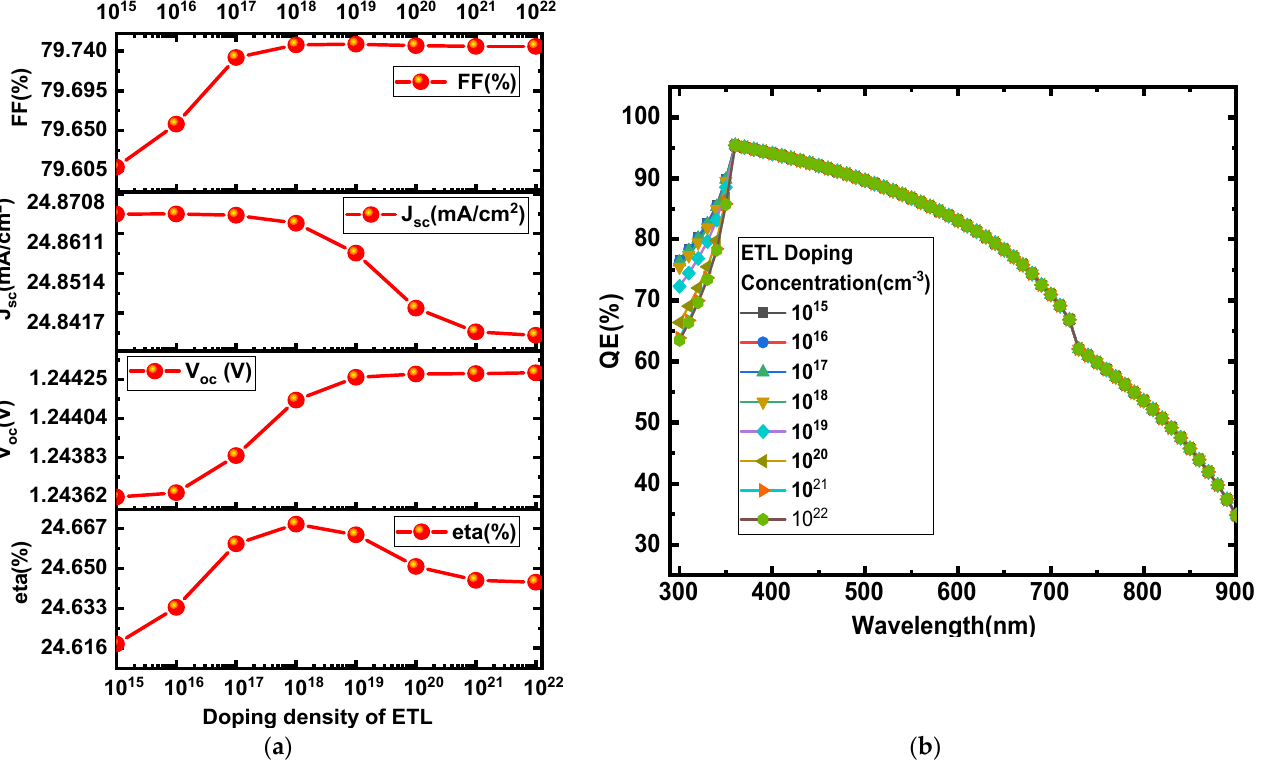
Figure 5. ( a ) Effect of doping density of the ETL on solar cell parameters (J sc , V oc , FF, and η ] ( b ) QE vs. wavelength.